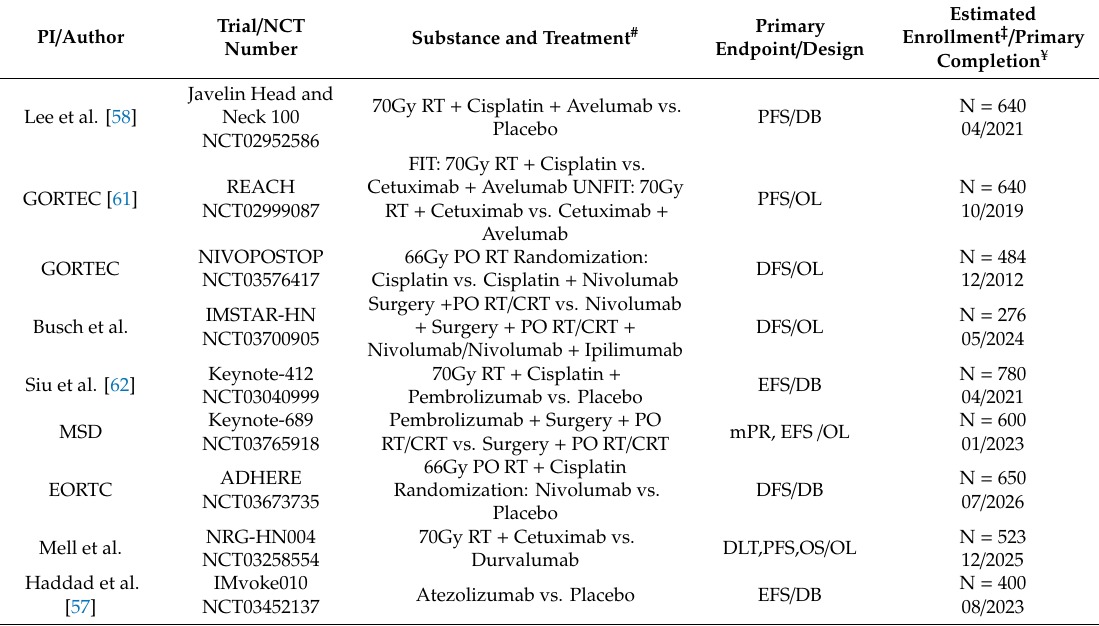
Table 2. Selected phase III clinical trials on immune-checkpoint inhibition for primary